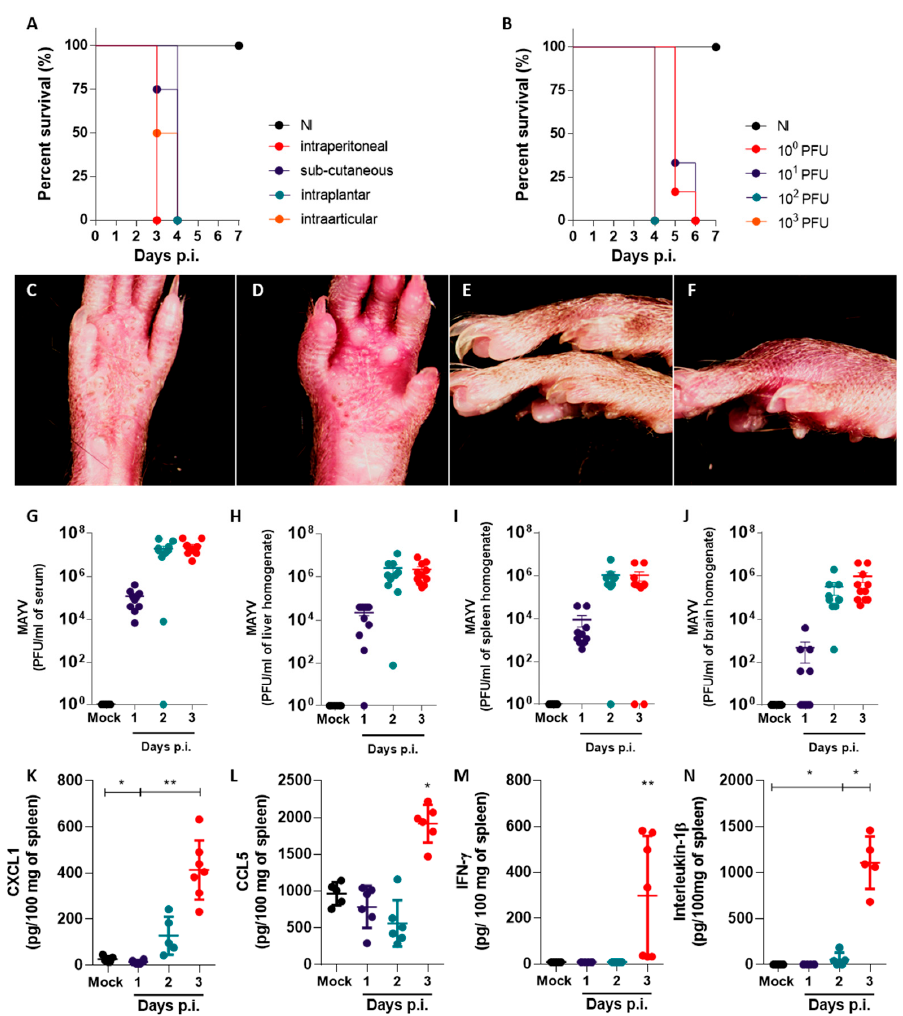
Figure 1. Footpad inoculation of MAYV in immunodeficient IFNAR − / − mice results in systemic infection and disease. ( A ) Survival curves in IFNAR − / − mice infected with 10 5 PFU by different inoculation routes. ( B ) Survival curves in IFNAR − / − mice infected with different concentrations of MAYV (10 0 , 10 1 , 10 2 , and 10 3 PFU) via intraplantar inoculation. ( C – F ) Representative photographs of mice hind paws injected with ( C , E ) PBS vehicle or ( D , F ) 10 2 PFU MAYV at day 3 p.i., showing inflammation signs (redness, swelling). ( G – J ) Viral load observed in ( G ) serum, ( H ) liver, ( I ) spleen and ( J ) brain of mock- and MAYV-infected mice at days 1 to 3 p.i. ( K – N ) Levels of the chemokines ( K ) CXCL1 and ( L ) CCL5 and the cytokines ( M ) IFN- γ and ( N ) IL-1 β observed in the spleen of mock- and MAYV-infected mice at days 1 to 3 p.i. PFU = Plaque Forming Units, p.i. = post-infection. Data presented as mean ± SEM. * p < 0.05, ** p <= 0.01 See also Supplementary Figures S1 and S2. Significant Reduction of Leukocyte Populations in the Spleen We assessed circulating and splenic leukocyte populations in MAYV-infected mice using total and differential counting and flow cytometry. Blood was collected from MAYV- and mock-infected mice at days 1, 2 and 3 p.i. The total and differential counting of leukocytes in blood smears indicated that MAYV-infected mice developed leukopenia